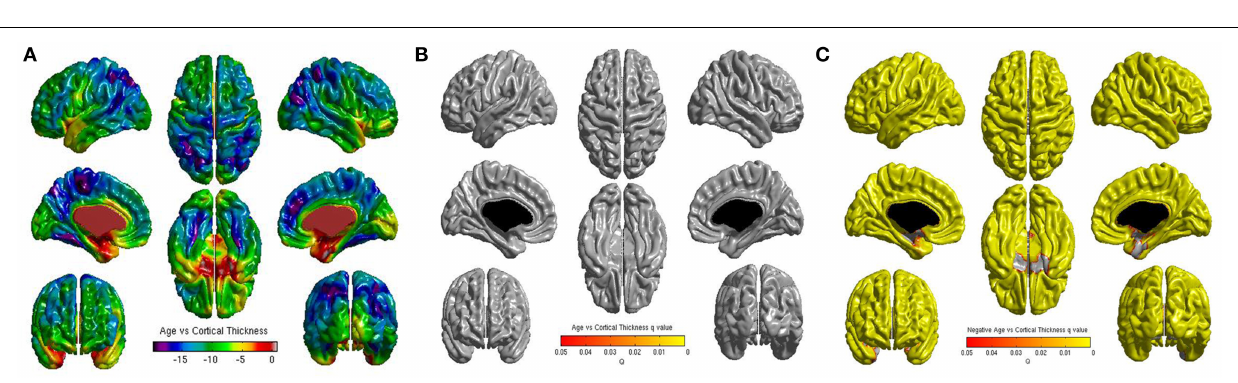
FIGURE 1 | (A) Unthresholded correlations between BMI Z-Score for age and cortical thickness across the entire brain, shown here for comparison. Typically T -values of around 4 or greater are needed to reach significance. (B) Positive correlations between BMI Z-Score for